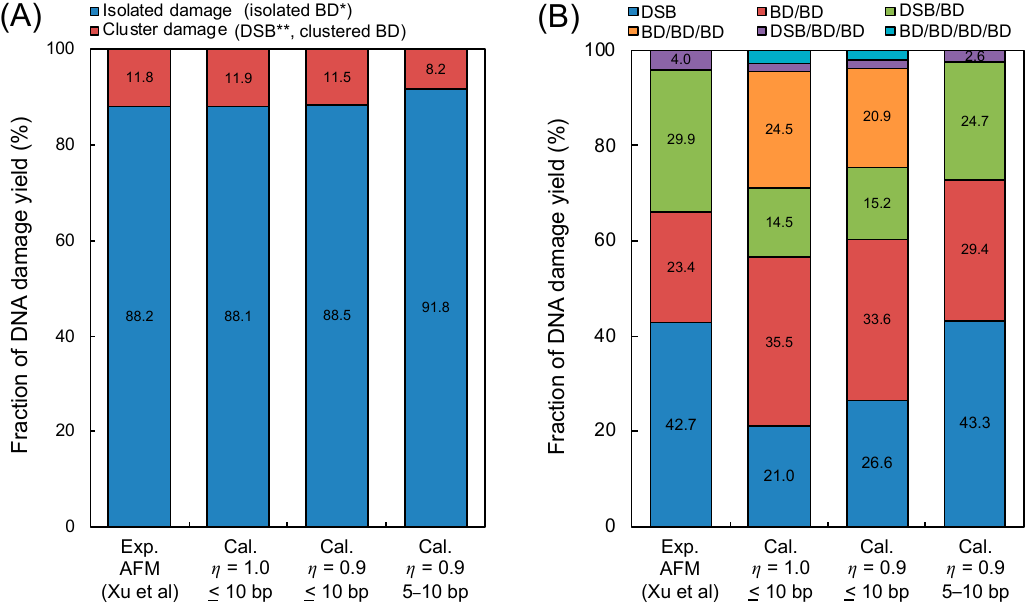
Figure 2. DNA damage complexity obtained by atomic force microscopy (AFM) imaging and simulation. ( A ) is the fraction of isolated base damage (BD) and complex damage (complex BD (cBD), double-strand break (DSB)); ( B ) is the type of complex DNA damage (DSB, BD/BD, DSB/BD, BD/BD/BD, DSB/BD/BD, BD/BD/BD/BD). The experimental results were obtained using AFM imaging for complex damage with BD reported by Xu et al. [41], where the energy of the X-ray is 70 kVp. The calculation represents the estimation based on Equations (2)–(5), where the determination of isolated or complex damage follows the summary in Table 1.